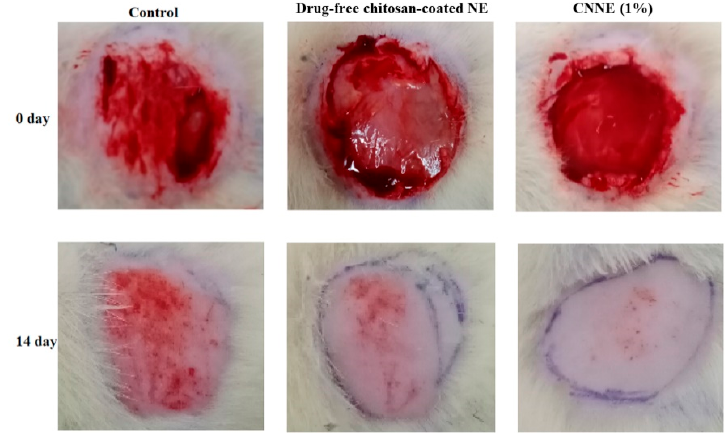
Figure 11. Representation of wound constructions in different experimental groups on the macroscopic measurements. Data are presented as mean ± SEM, where * p < 0.05 compared to the control group ( n = 6).